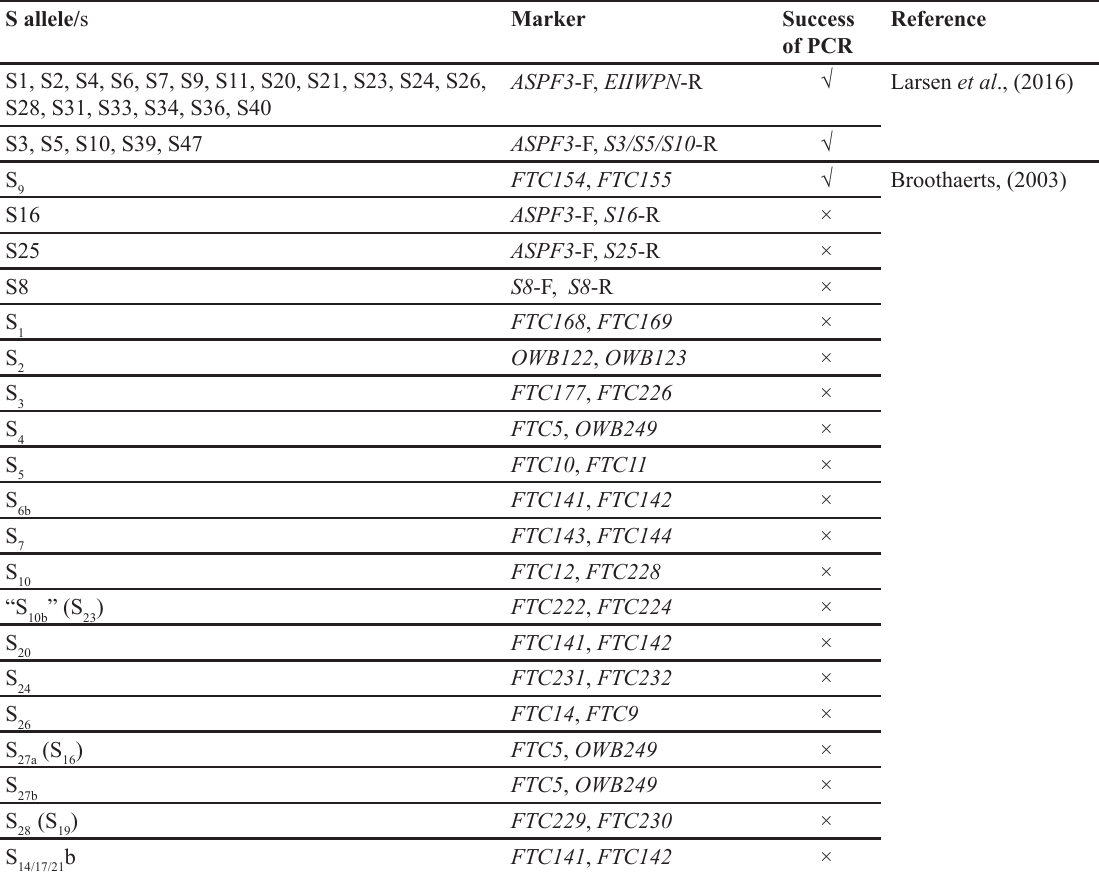
Reference of PCR ASPF3 -F, EIIWPN